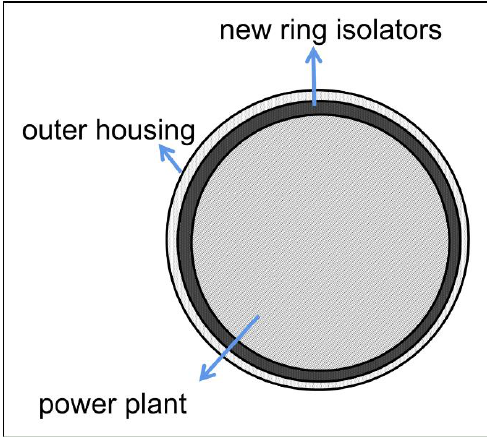
Figure 7. Schematic diagram of the new vibration isolators.